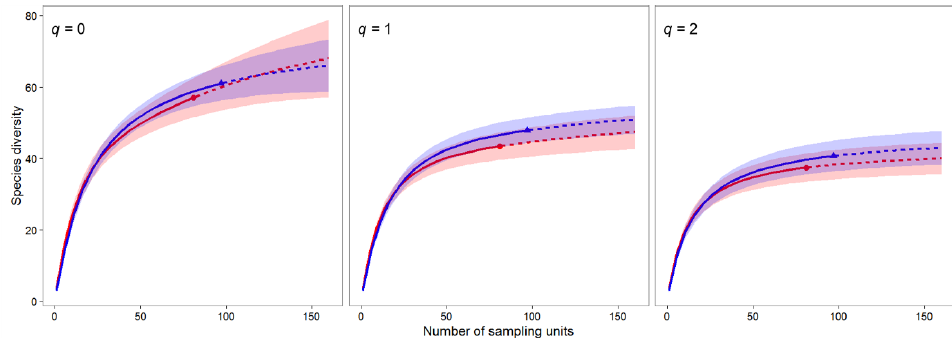
Figure 2. Sample-size-based rarefaction (solid lines) and extrapolation (dashed lines) of fish diversity at the Upper Paraná River (Hill numbers of order 0, 1 and 2). q = 0: species richness; q = 1: Shannon diversity; q = 2: inverse of Simpson’s concentration. Blue: tributaries; red: Paraná River.